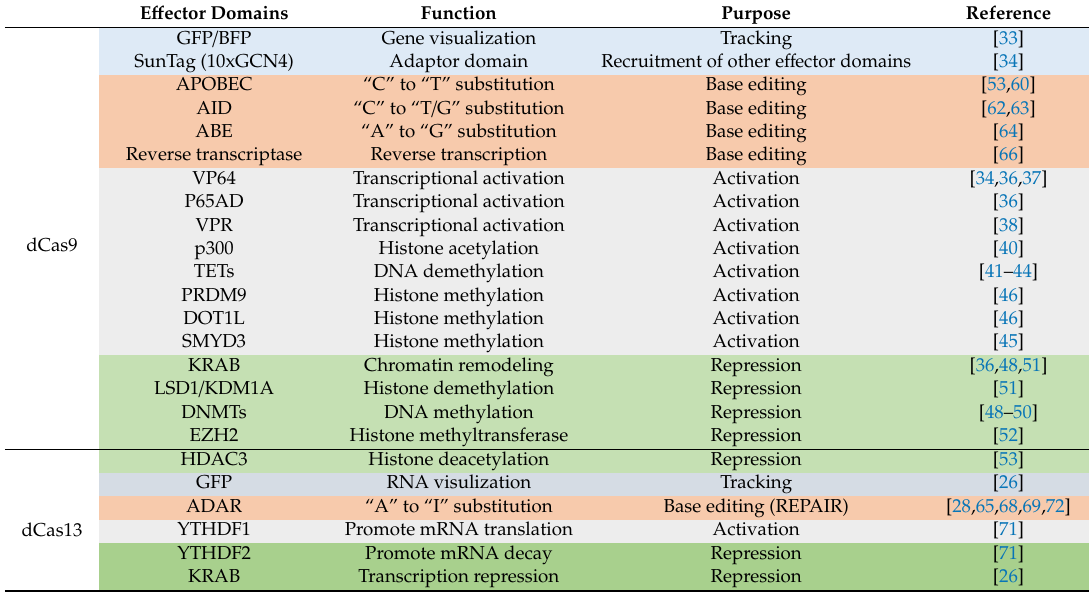
Table 3. dCas protein derived gene modulators. Colors indicate di ff erent